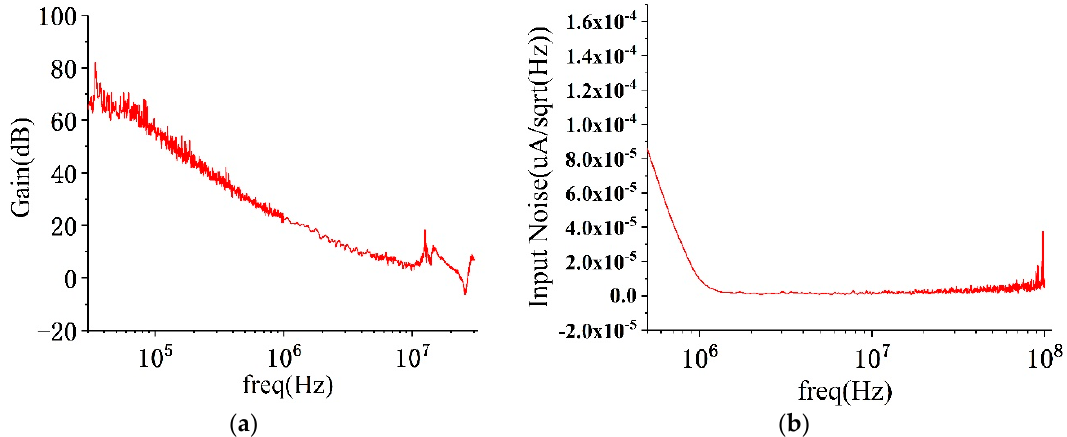
Figure 5. Measurements of the amplifer chip performance. ( a ) The result of open-loop gain; and ( b ) measurement of the input reference noise current.